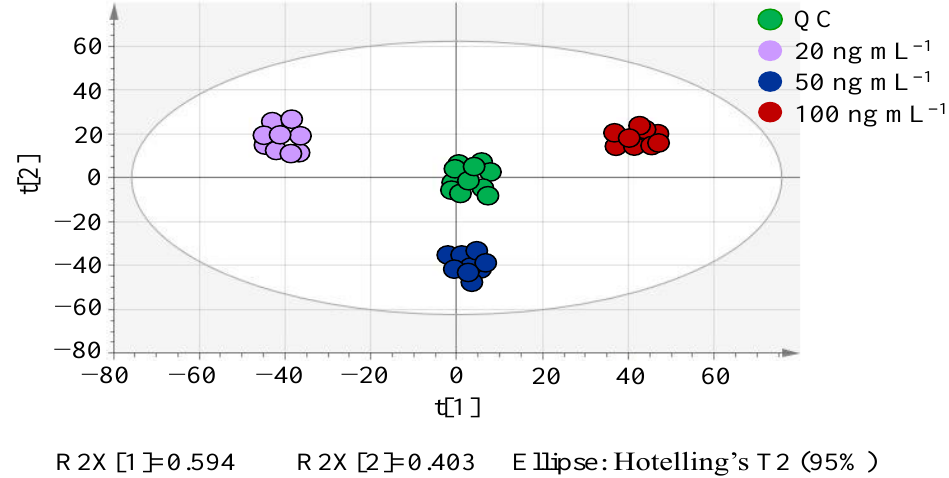
Figure 2. PCA score plot of spiked lettuce sample groups.